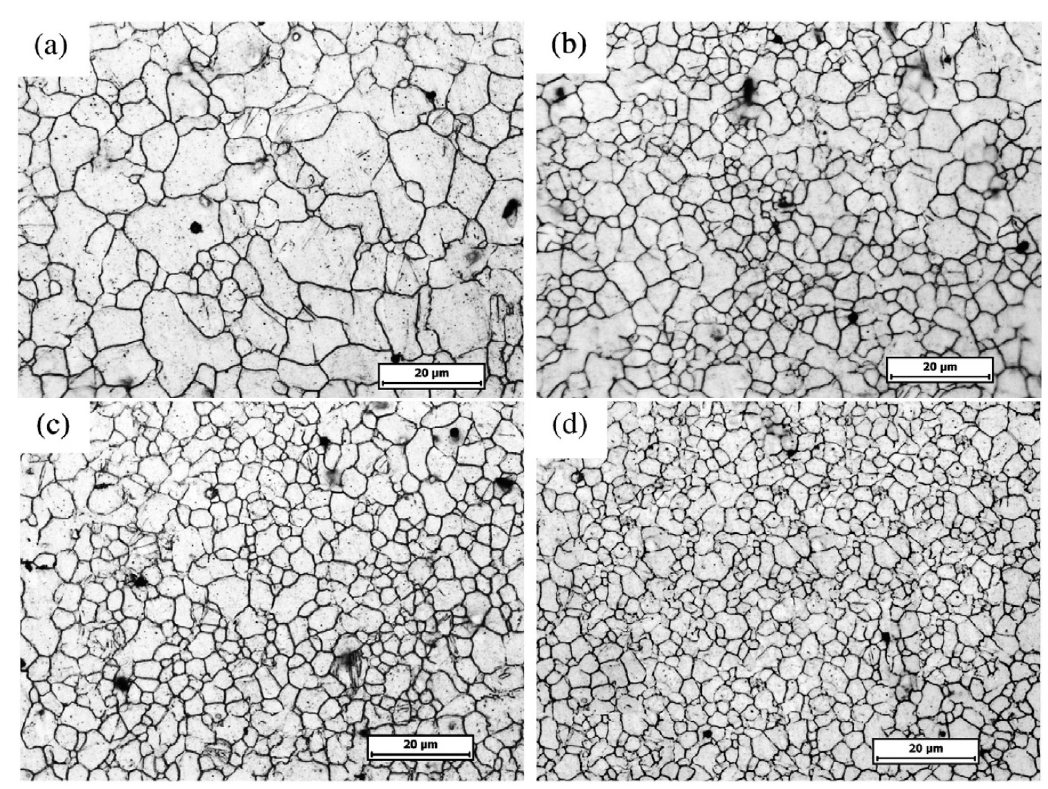
Figure 13. Optical macrographs of AZ31B Mg alloy surface ( a ) before LSP; ( b ) one impact; ( c ) two impacts; and ( d ) four impacts